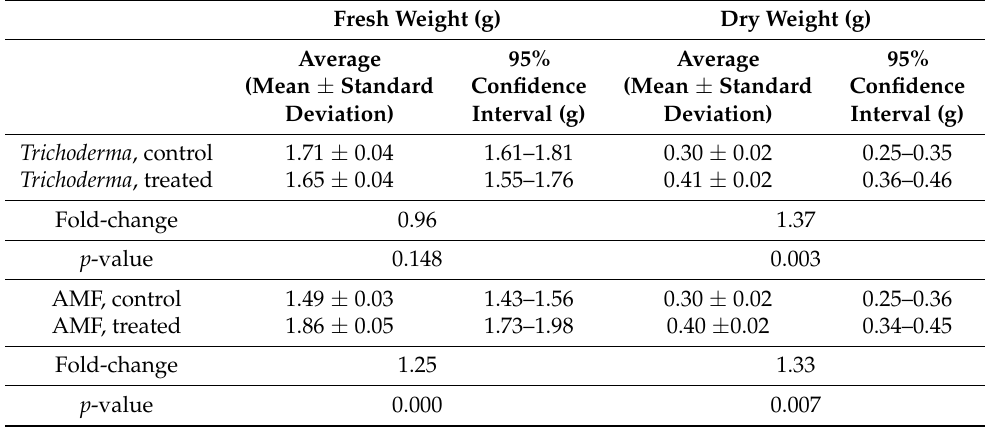
Table 1. Biomass data for tomato plants treated with AMF and Trichoderma with statistical